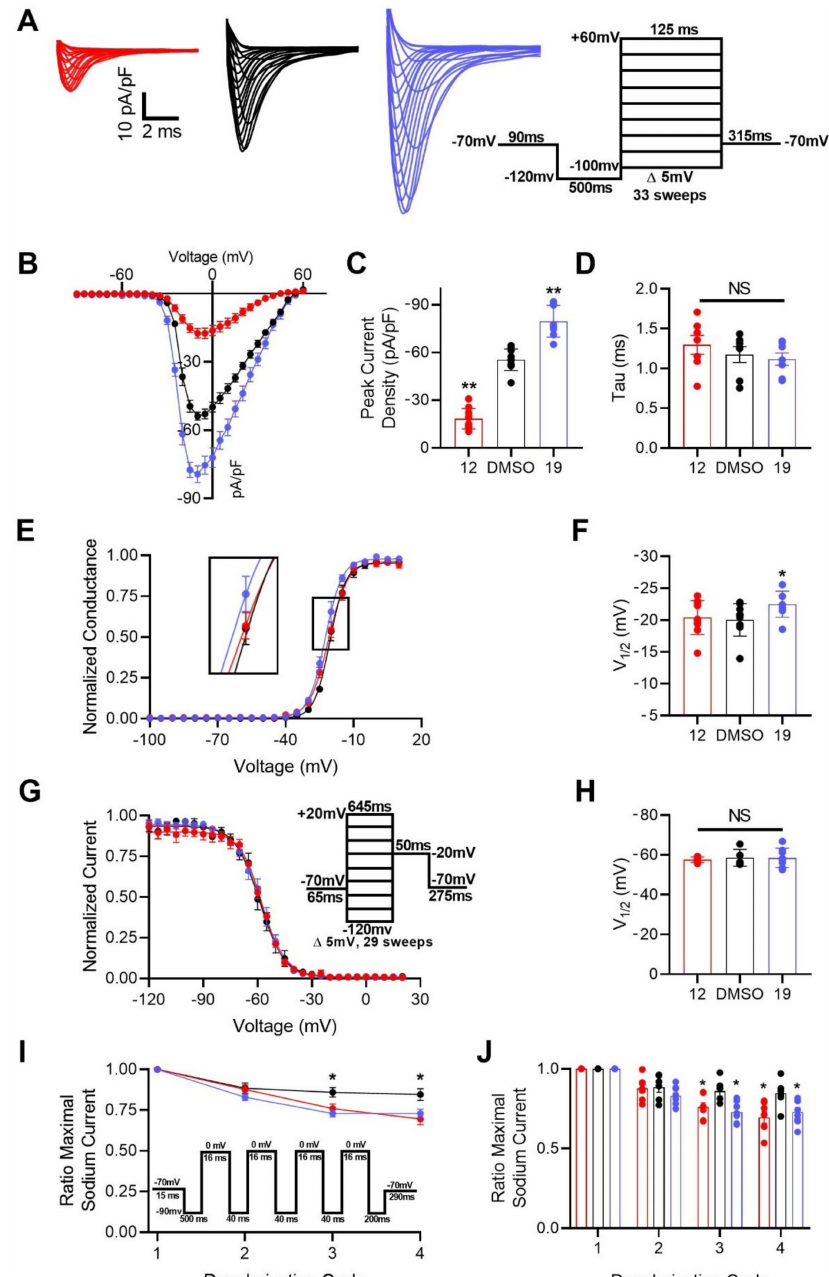
Figure 5. Functional evaluation of 12 and 19 as modulators of Nav1.6 using whole-cell patch-clamp electrophysiology. ( A ) Representative traces of Na + transient currents recorded from HEK-Nav1.6